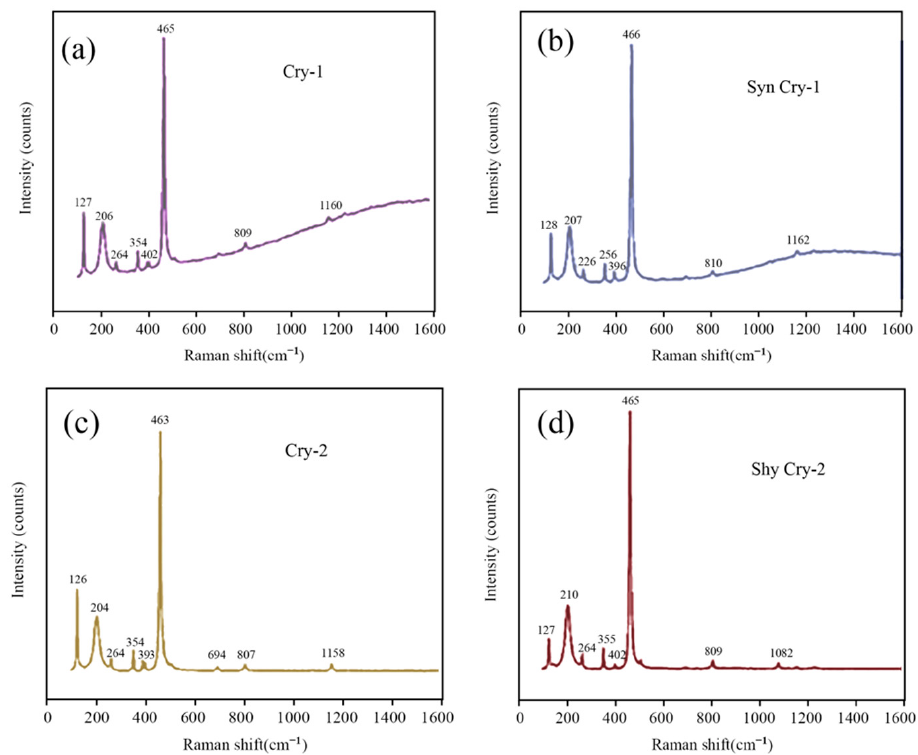
Figure 4. The Raman spectra of Cry-1 ( a ), Syn Cry-1 ( b ), Cry-2 ( c ) and Syn Cry-2 ( d ) samples.